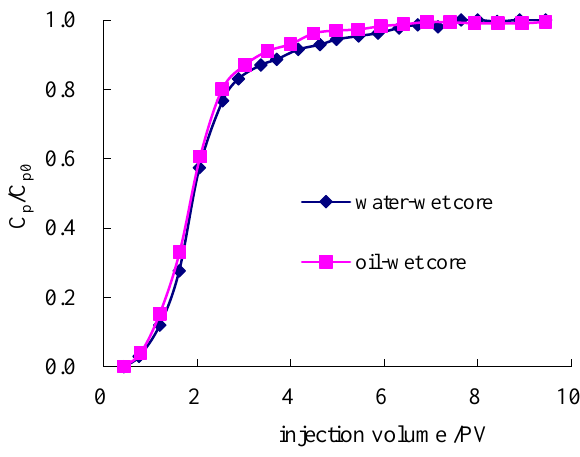
Figure 12. The dynamic adsorption of polymers.